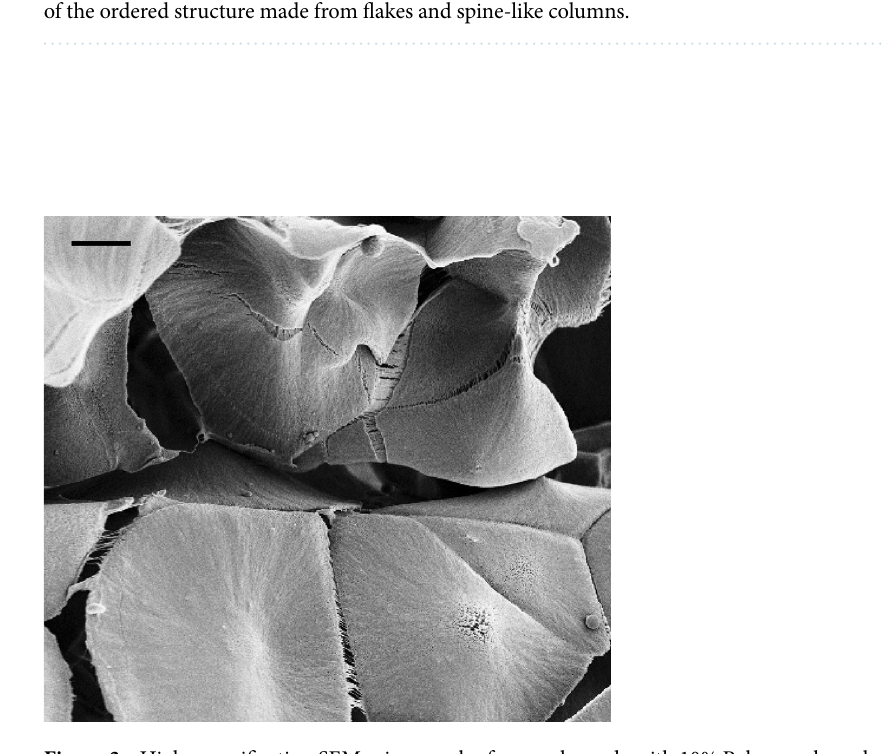
Figure 3. High magnification SEM micrograph of a sample made with 10% Polypropylene showing polymer flakes attached to each other by very thin fibres, presumably in the nanometer scale. Scale bar = 5